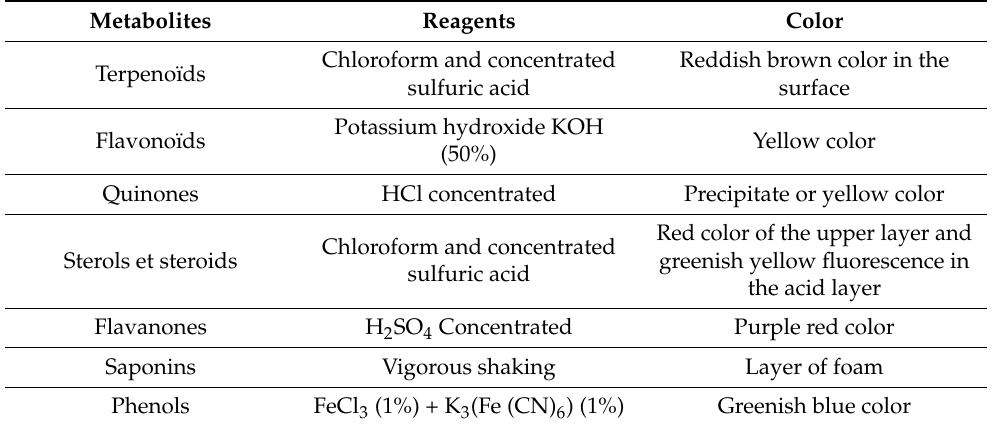
Table 1. Cont. Metabolites Reagents Color Chloroform and concentrated Reddish brown color in the Terpenoïds sulfuric acid surface Potassium hydroxide KOH Yellow color Flavonoïds (50%) Quinones HCl concentrated Precipitate or yellow color Red color of the upper layer and Chloroform and concentrated Sterols et steroids greenish yellow fluorescence in sulfuric acid the acid layer Flavanones H 2 SO 4 Concentrated Purple red color Saponins Vigorous shaking Layer of foam